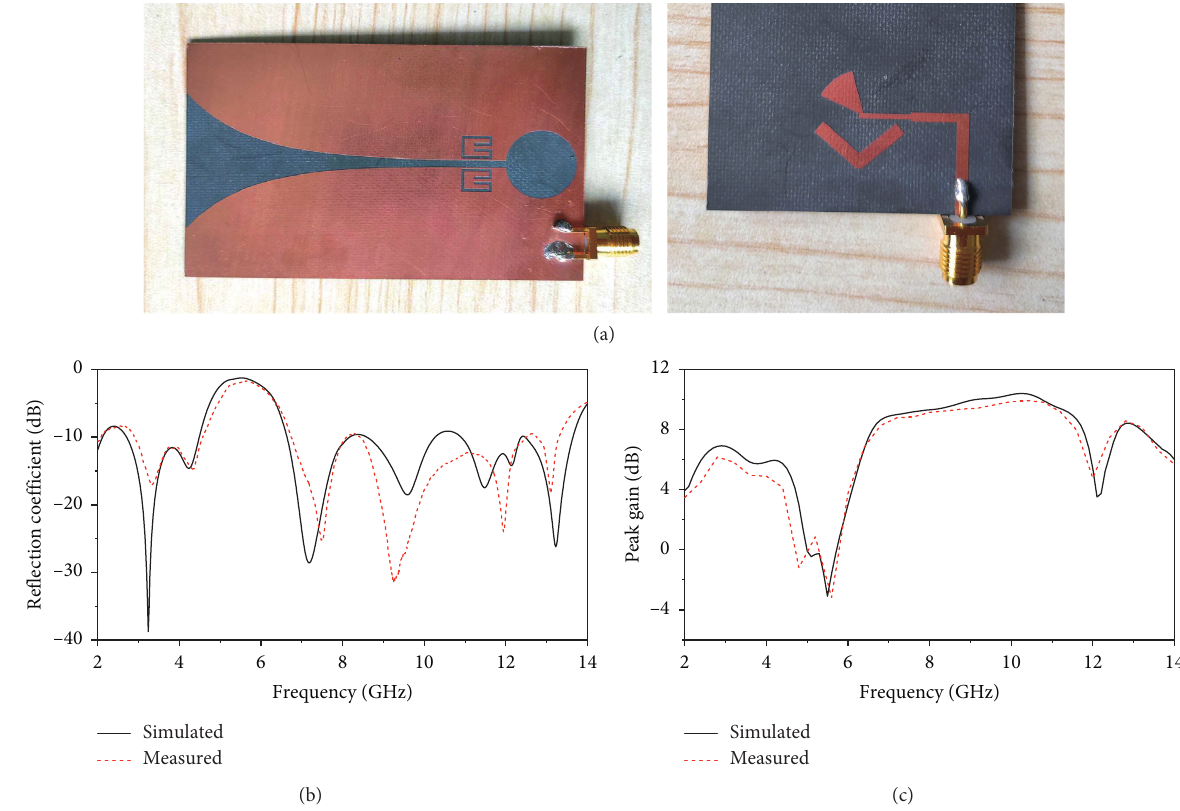
Figure 9: (a) Fabricated prototype of the Vivaldi antenna loaded with HWR/CCLL. (b) Simulated and measured S11 characteristics of the fabricated prototype with HWR/CCLL loading. (c) Measured and simulated gain characteristics of the fabricated prototype with HWR/ CCLL